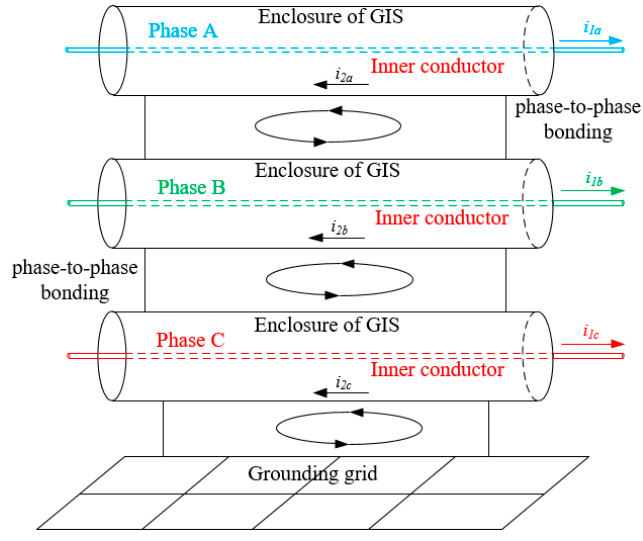
Figure 3. Loop composed of different phase and grounding grid.